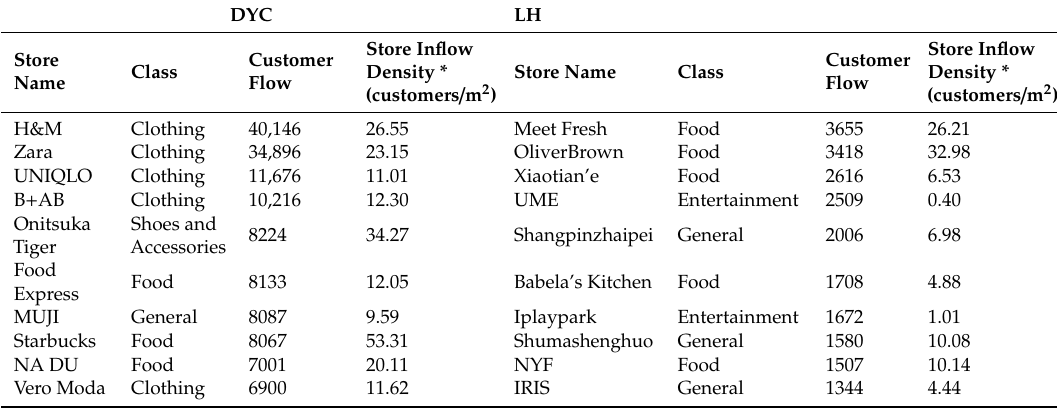
Table 4. Top 10 stores for average customer flows in DYC and